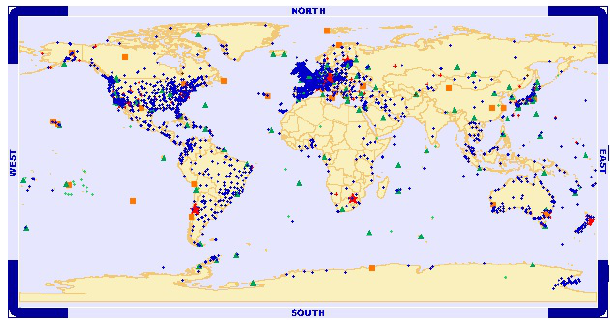
Fig. 2. Map illustrating distribution of space geodetic techniques (Source: http://itrf.ensg.ign.fr/GIS/).